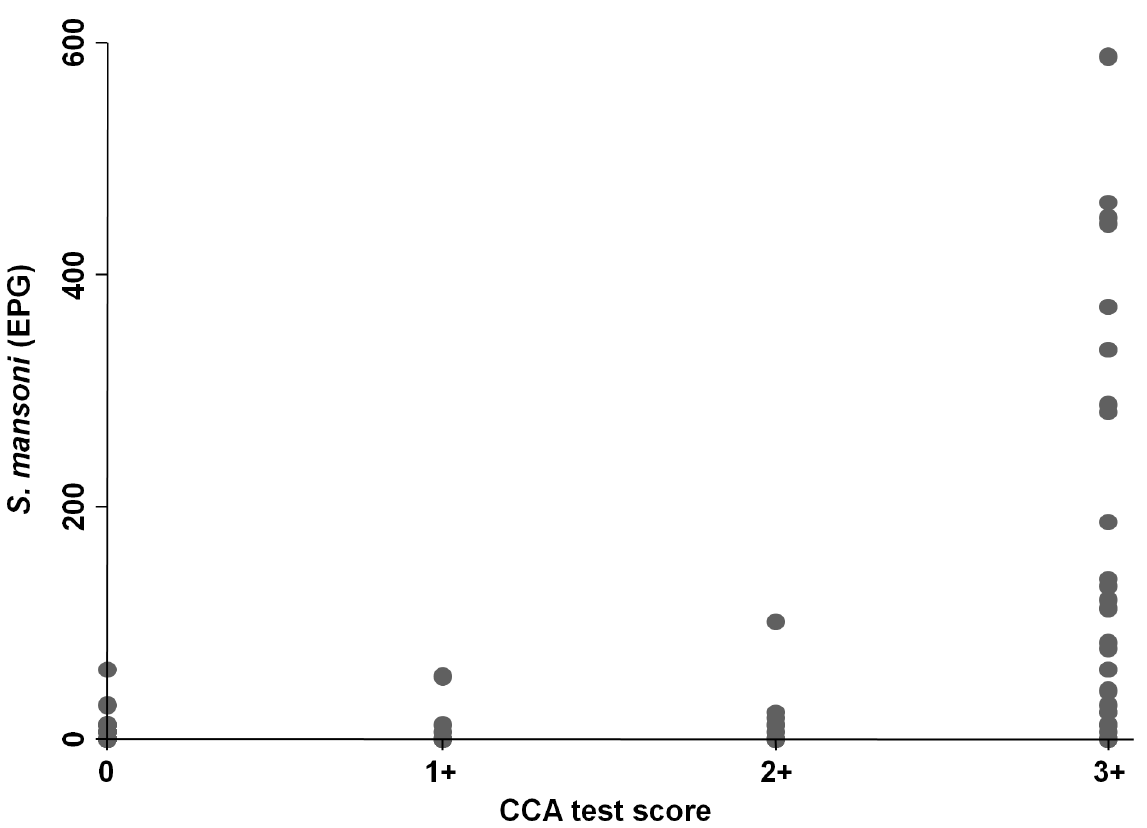
Figure 2. Correlation between S.mansoni egg counts and CCA test color reaction scores. This figure shows the correlation between S. mansoni eggs per gram of stool (EPG) values, as determined by quadruplicate Kato-Katz thick smears, and a single urine CCA cassette test with ‘trace’ considered as negative result (negative (0), 1 + , 2 + , and 3 + . doi:10.1371/journal.pntd.0002109.g002 CCA(t 2 ) revealed a sensitivity and NPV of 80.0% and 92.4%,